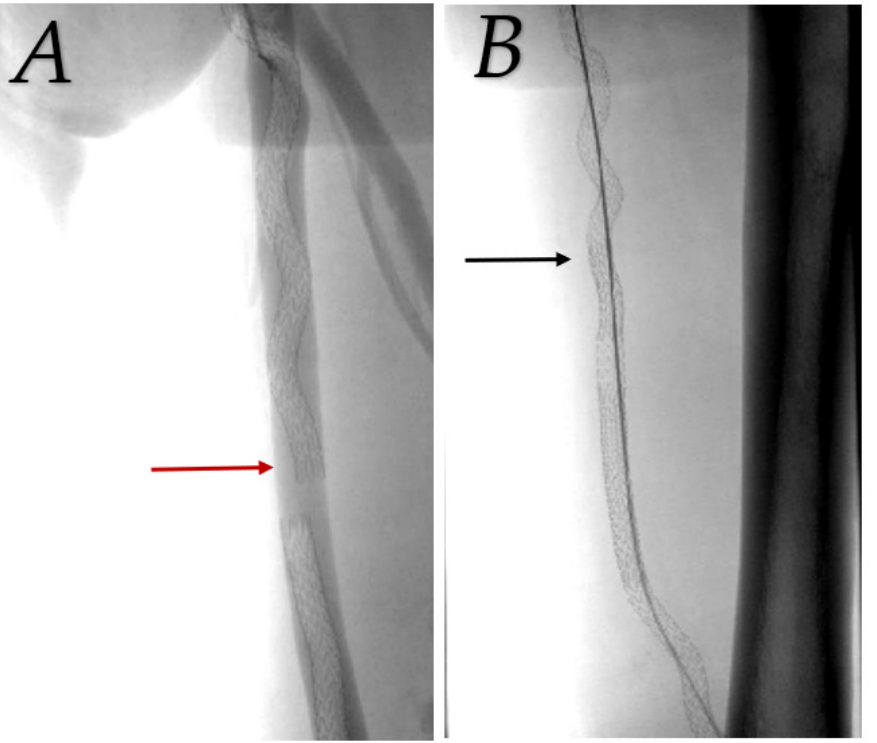
Figure 3. Detachment of stent grafts due to insufficient overlap (red arrow), arterial flow into femoral vein ( A ). Treated with bridging stent graft (black arrow, image ( B )).